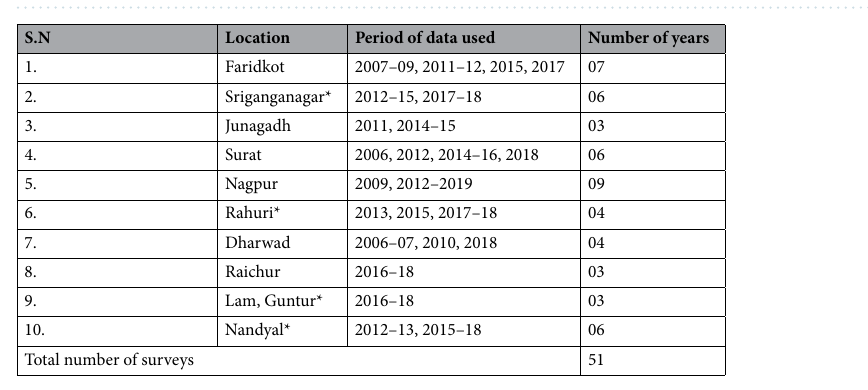
Figure 8. The map of India showing the observation stations and study area.